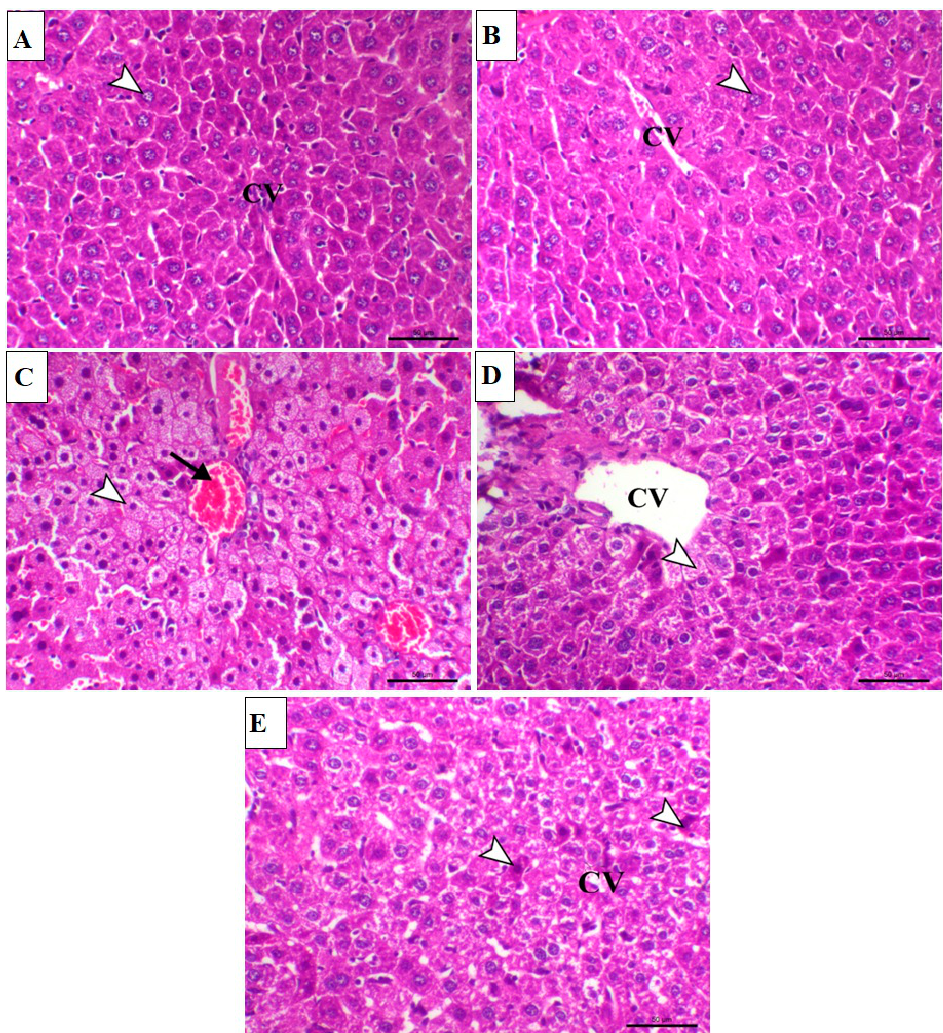
Figure 2. PU ameliorates MTX-induced histopathological alterations in the liver. Image of hepatic sections from ( A ) control mice showing normal hepatic cells (arrowhead) arranged in cords and separated with sinusoids around the central vein (CV); ( B ) PU-treated animals demonstrating normal hepatocytes (arrowhead) around the central vein (CV), ( C ) MTX-treated animals demonstrating congestion of hepatic blood vessels (arrow) and marked granular hepatic vacuolation associated with marked nuclear pyknosis (arrowhead); ( D ) MTX-administered mice pre-treated with 25 mg PU showing marked decreased hepatic vacuolation which restricted mostly centrilobular (arrowhead) (CV indicates central vein); and ( E ) MTX-administered animal group pre-treated with 50 mg PU demonstrating noticeable decrease in hepatic vacuolation with few cellular apoptosis (arrowheads) (CV indicates central vein) (H&E, X200, Scale bar = 50 µm).